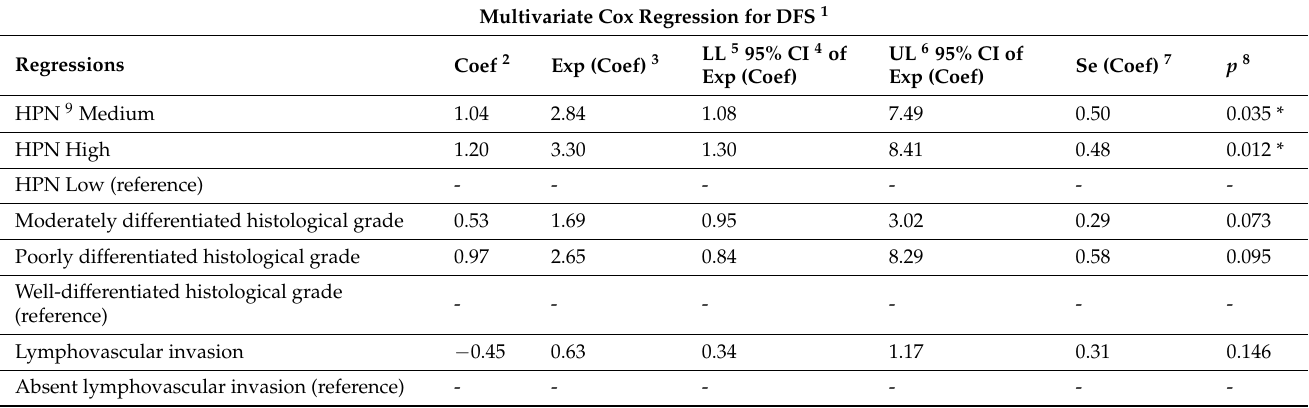
Table 2. Multivariate Cox regression model for disease-free survival in localized patients at